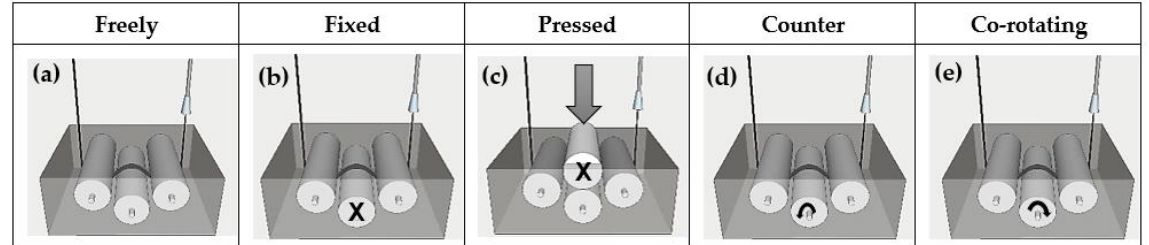
Figure 12. Schematic drawing with varied roller configurations: ( a ) all roller freely rotatable; ( b ) fixed central roller; ( c ) pressed central roller from the top; ( d ) central roller counter rotating; ( e ) central roller co-rotating.